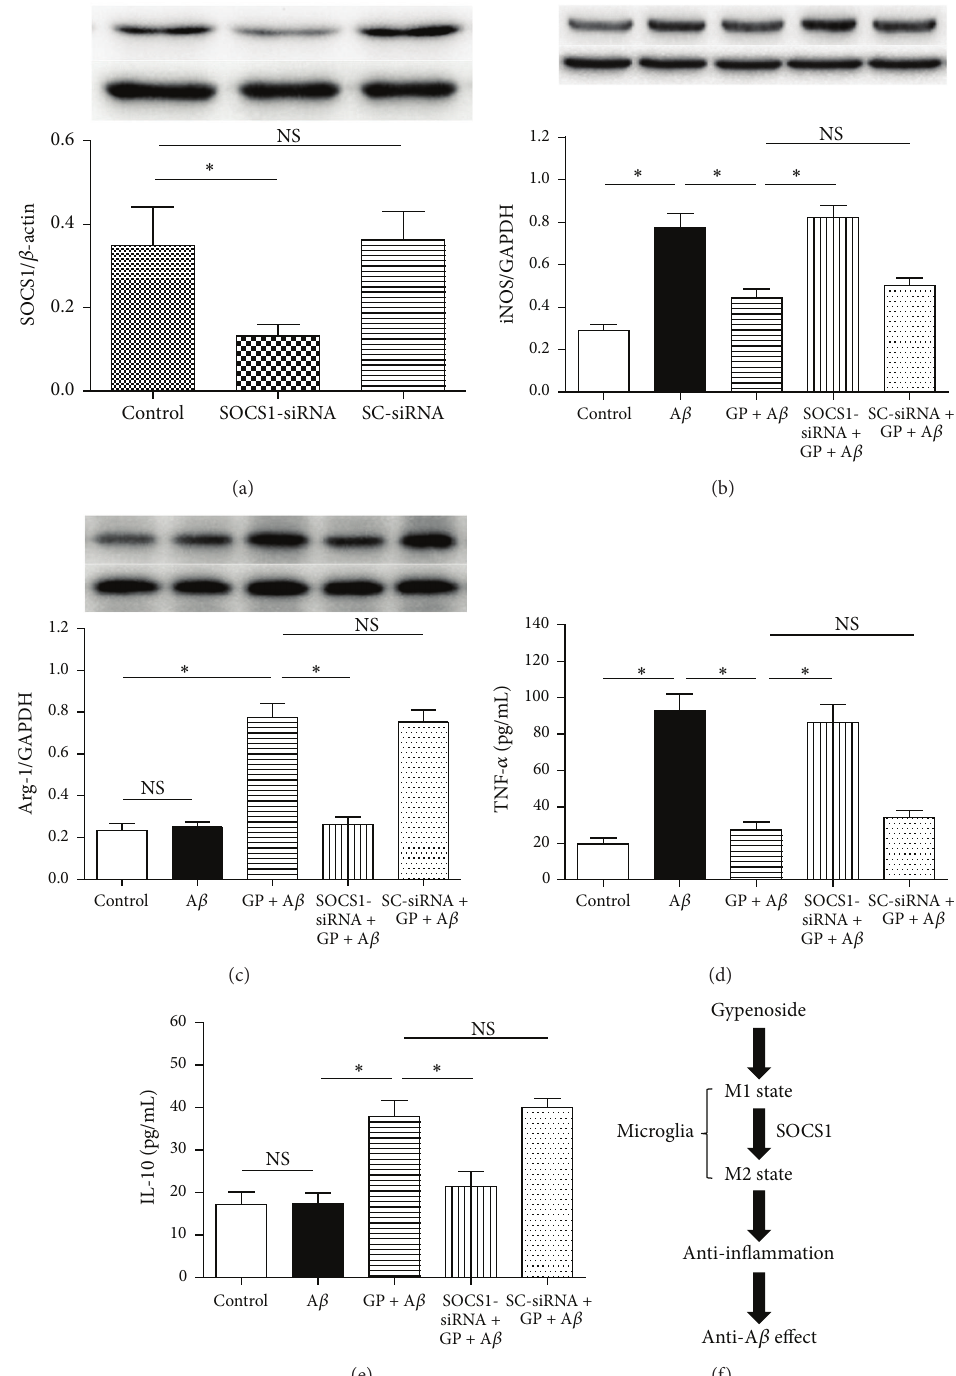
Figure 6: SOCS1-siRNA abolished GP-induced effects on iNOS and Arg-1 expressions and TNF- 𝛼 and IL-10 releases. Western blot was taken to evaluate the SOCS1-siRNA-induced effect on SOCS1 protein expression ((a), 𝑛 = 4 ). Then the cells were divided into five groups, including control: cells cultured in normal medium; A 𝛽 : cells cultured in the medium containing 10 𝜇 M A 𝛽 ; GP + A 𝛽 : cells cultured in the medium containing 50 𝜇 g/mL GP and 10 𝜇 M A 𝛽 ; SOCS1-siRNA + GP + A 𝛽 : cells treated with SOCS1-siRNA for 6h and then exposed to the medium containing 50 𝜇 g/mL GP and 10 𝜇 M A 𝛽 ; SC-siRNA + GP + A 𝛽 : cells treated with scrambled (SC)-siRNA for 6h and then exposed to the medium containing 50 𝜇 g/mL GP and 10 𝜇 M A 𝛽 . After 24-h incubation, the iNOS and Arg-1 expressions were evaluated by using western blot analysis ((b)-(c), 𝑛 = 4 ), and TNF- 𝛼 and IL-10 concentrations were assessed by using ELISA kits ((d)-(e), 𝑛 = 6 ). (f) Hypothetical model of SOCS1 mediates GP-induced anti-A 𝛽 effect by switching microglia from M1 to M2 state. Data are means ± SD, ∗ : 𝑃 < 0.05 , NS: no